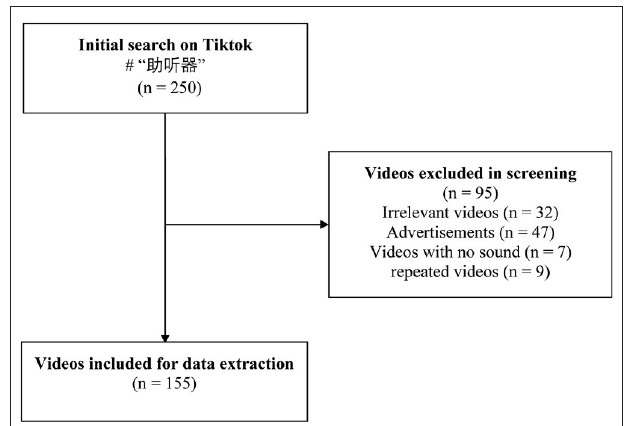
FIGURE 1 | Video screening